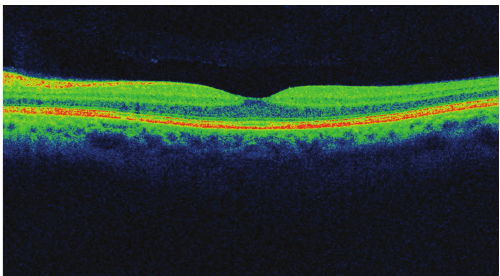
Figure 5: Regression of DME after one anti-VEGF intraocular injection—patient from Figure